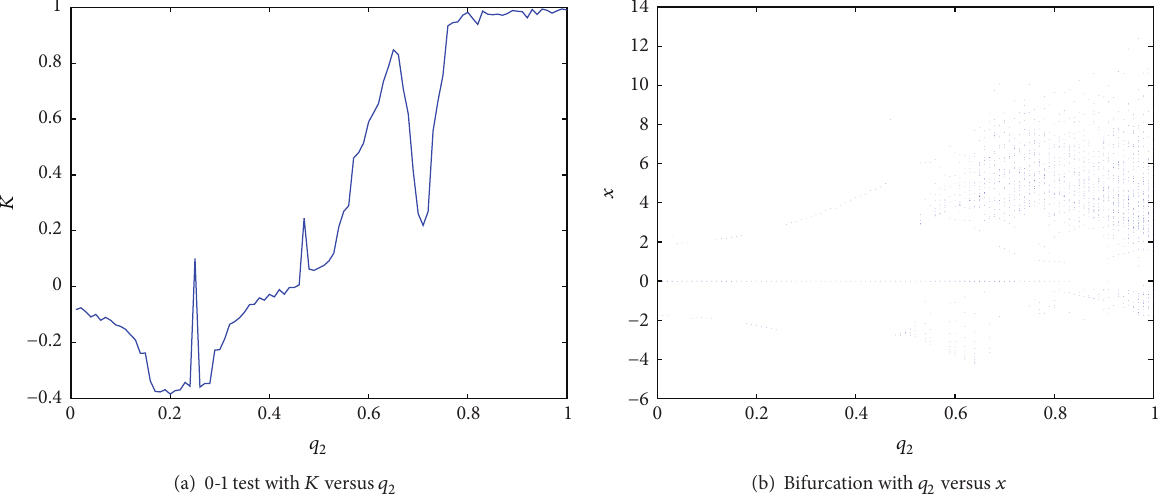
Figure 5: The evolvement of 𝐾 and 𝑥 versus 𝑞 2 with 𝑞 1 = 0.98 , 𝑞 3 = 0.97 , 𝑞 4 = 0.78 , 𝑎 = 3 , 𝑏 = 0.4 , 𝑐 = 0.4 , and 𝑑 = 0.1